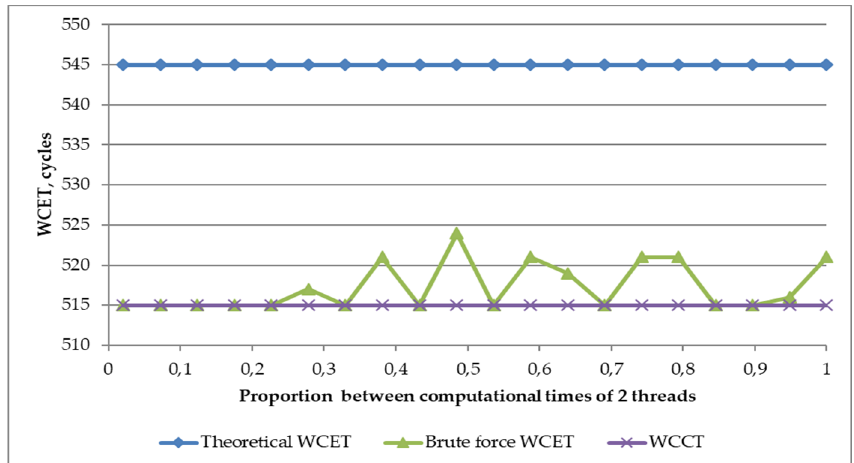
Figure 1. Experimental results with two threads, illustrating the theoretical WCET value to brute- force WCET to highlight the overestimation problem.